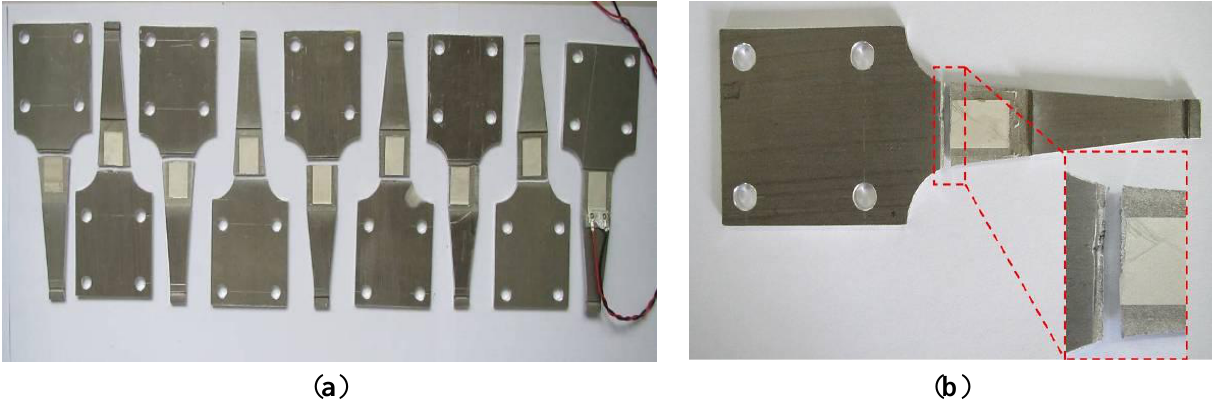
Figure 22. Photos of the damaged specimen. ( a ) Damaged specimen; and ( b ) Fracture